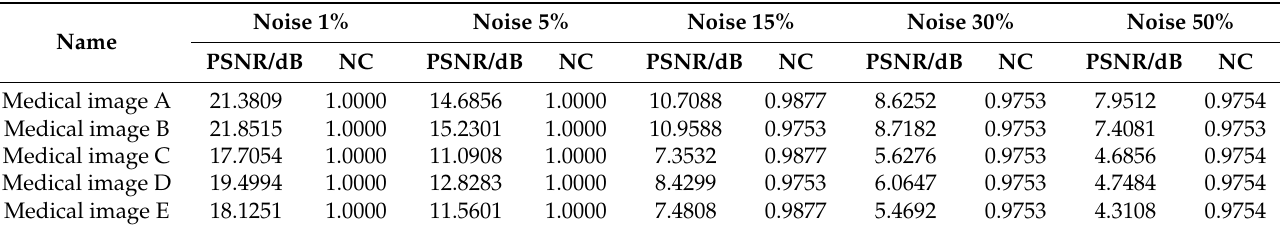
Figure 9. Attacked medical images and restored watermarking images under Gaussian noise 30%: ( a , a1 ) brain and extracted watermarking image; ( b , b1 ) chest and extracted watermarking image; ( c , c1 ) fundus blood vessels and extracted watermarking image; ( d , d1 ) hand and extracted watermarking image; and ( e , e1 ) breast and extracted watermarking image. Table 1. The result under Gaussian noise